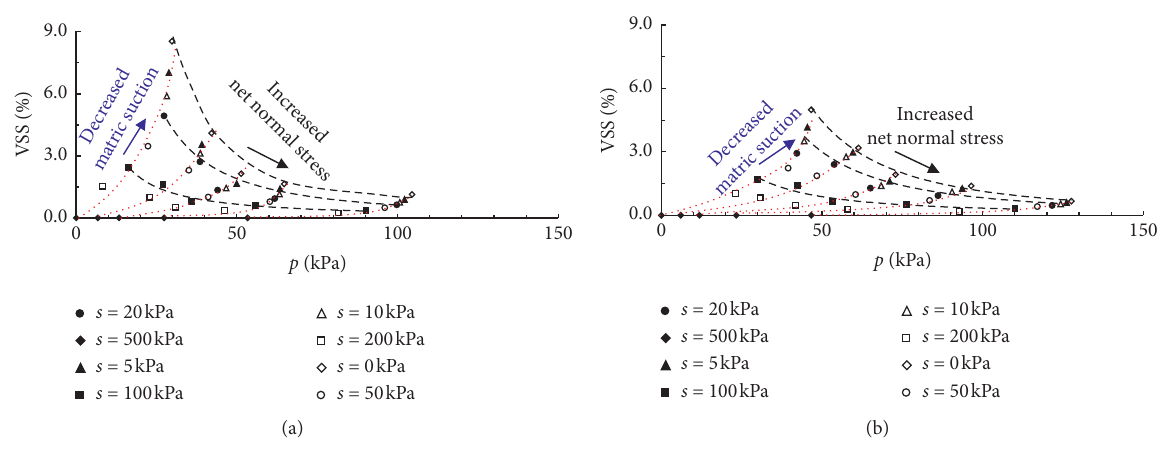
Figure 8: Variation of VSS under different matric suction with mean net stress in (a) VS test and (b) LS test. Table 3: Fitting results of (2) for VS and LS test series. Fitting parameters VS test series